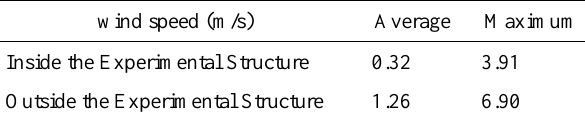
Table 3 Summary of wind speed of Experimental Structure and different caves